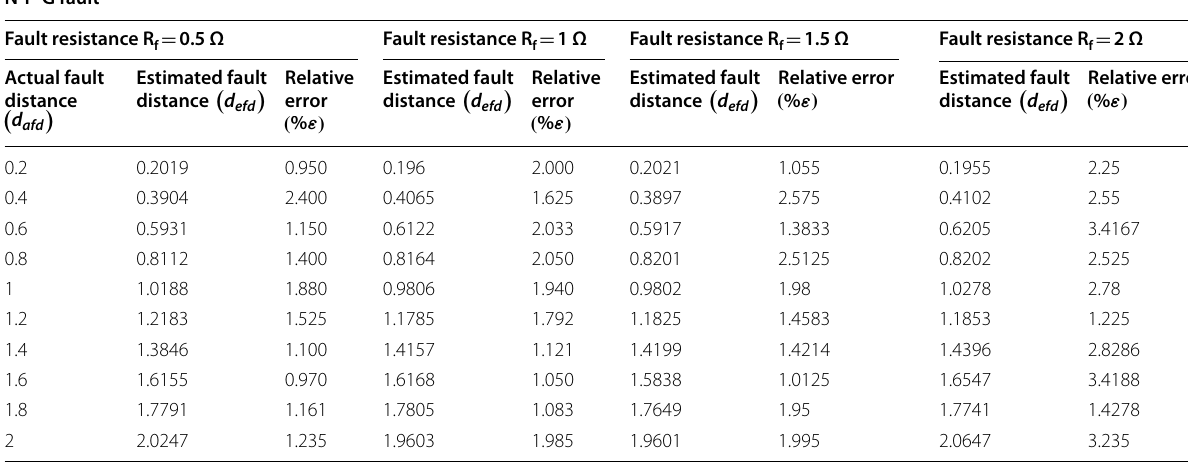
Table 10 N-P-G fault distance estimation by the FF-RLS algorithm N‑P‑G fault Fault resistance R f 0.5 Ω =